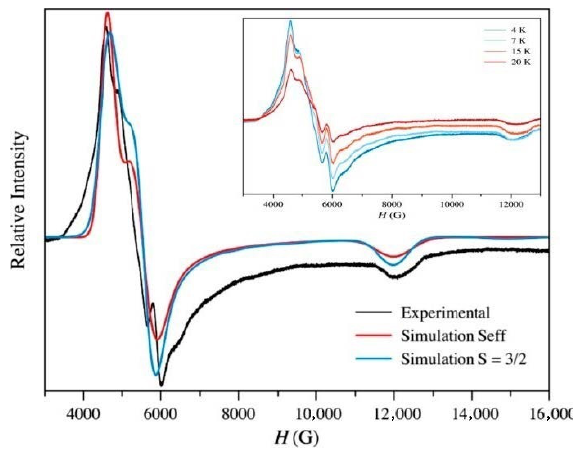
Figure 5. Q-band EPR spectrum of a crushed sample of 1 at 4.0 K (black trace). The grey and black traces correspond to the best simulations for an effective spin S eff = ½ and an anisotropic spin S = 3/2 respectively (see text). Inset: The thermal evolution of the EPR spectra from 20 (red) to 4.0 K (blue).